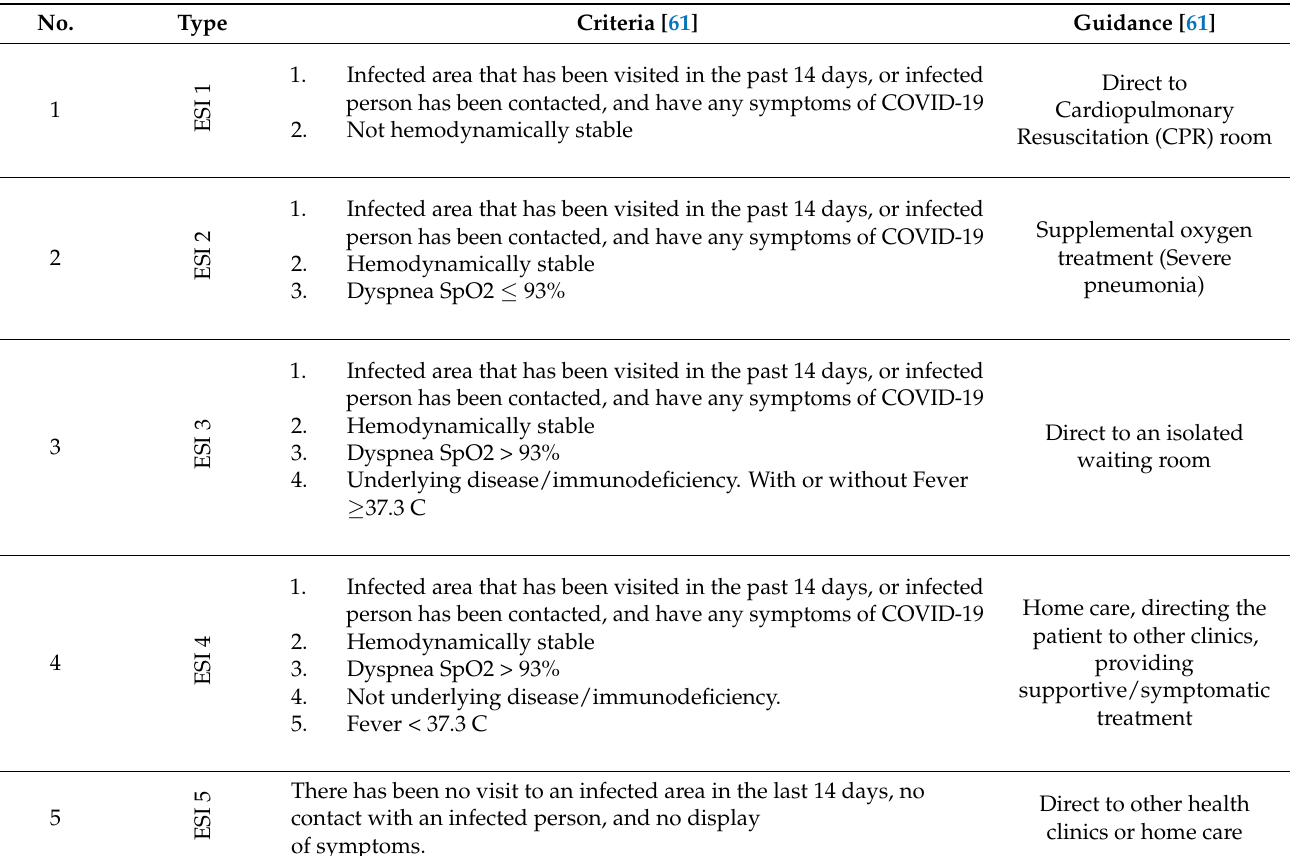
Table 6. Classification criteria of COVID-19 patients in approach